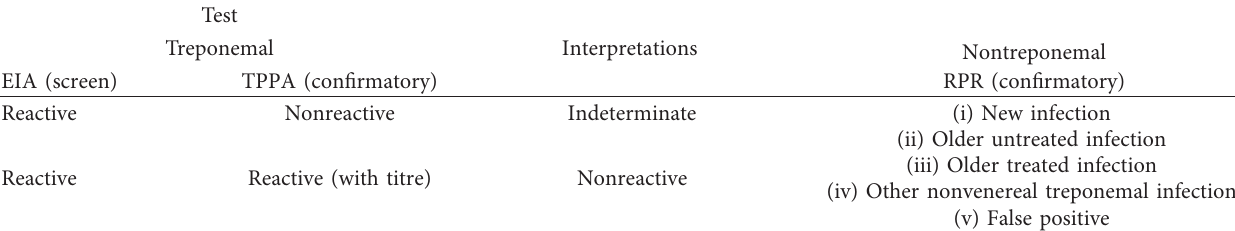
Table 1: Inconclusive results and